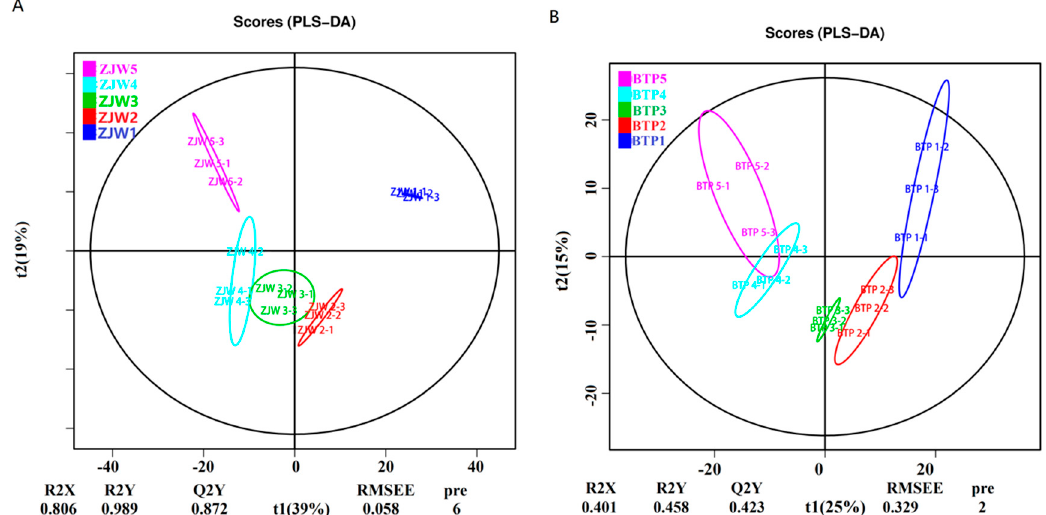
Figure 2. PLS-DA score plots generated from PLS-DA models in different development stages of tea flower. ( A ) PLS-DA score plot of ZJW flower; R2X = 0.806, R2Y = 0.989, Q2Y = 0.872; ( B ) PLS-DA score plot of BTP flower; R2X = 0.401, R2Y = 0.458, Q2Y = 0.243; RMSEE represent Root Mean Square Error of Estimation.